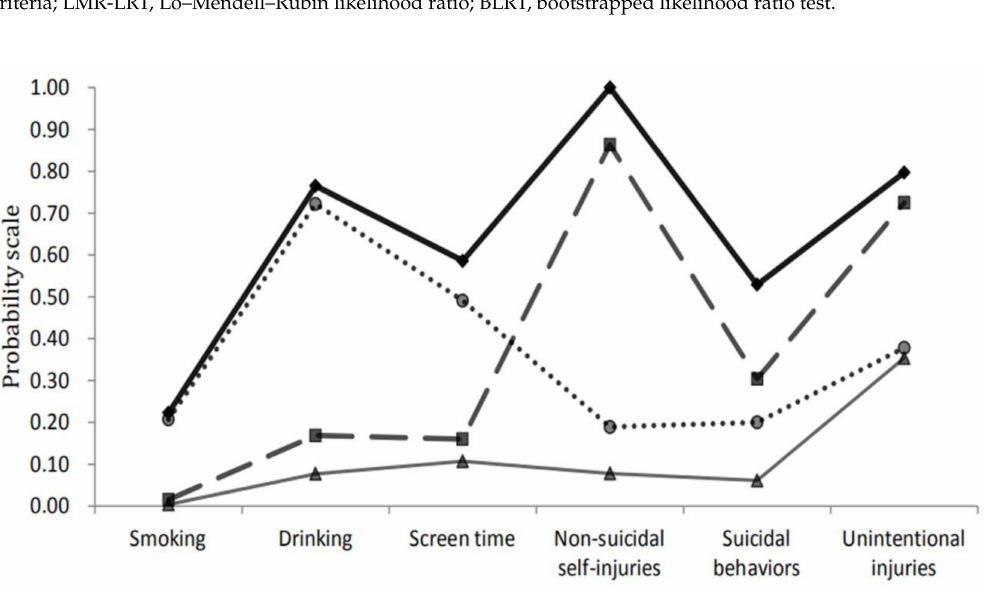
Figure 1. Four classes of health risk behaviors (HRBs) of the best-fitting four-class pattern. (cid:78) Low-risk class, 64.0%; • Moderate-risk class 1 (smoking, drinking, and screen time), 4.5%; (cid:4) Moderate-risk class 2 (non-suicidal self-injuries, suicidal behaviors, and unintentional injuries), 28.8%; (cid:7) High-risk class,